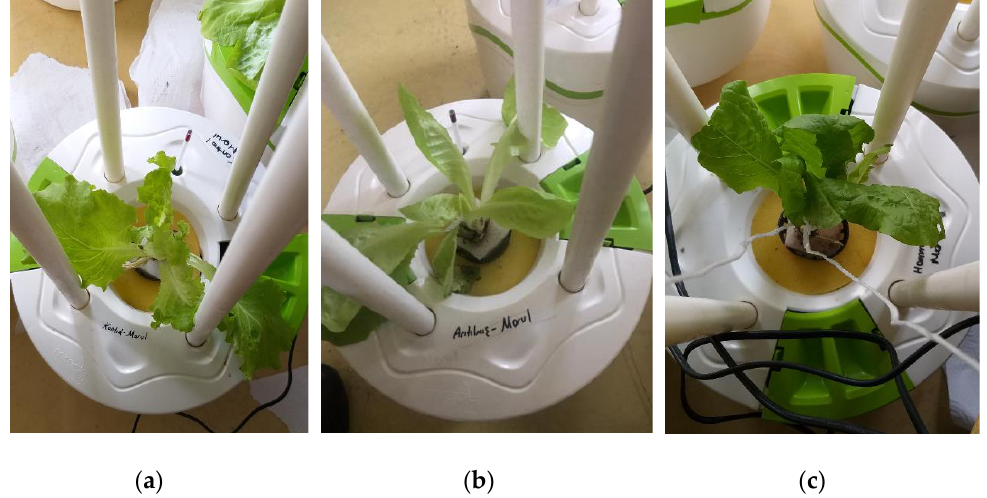
Figure 10. The images of lettuces irrigated with ( a ) tap water, ( b ) PECM treated wastewater, ( c ) BTTWW.